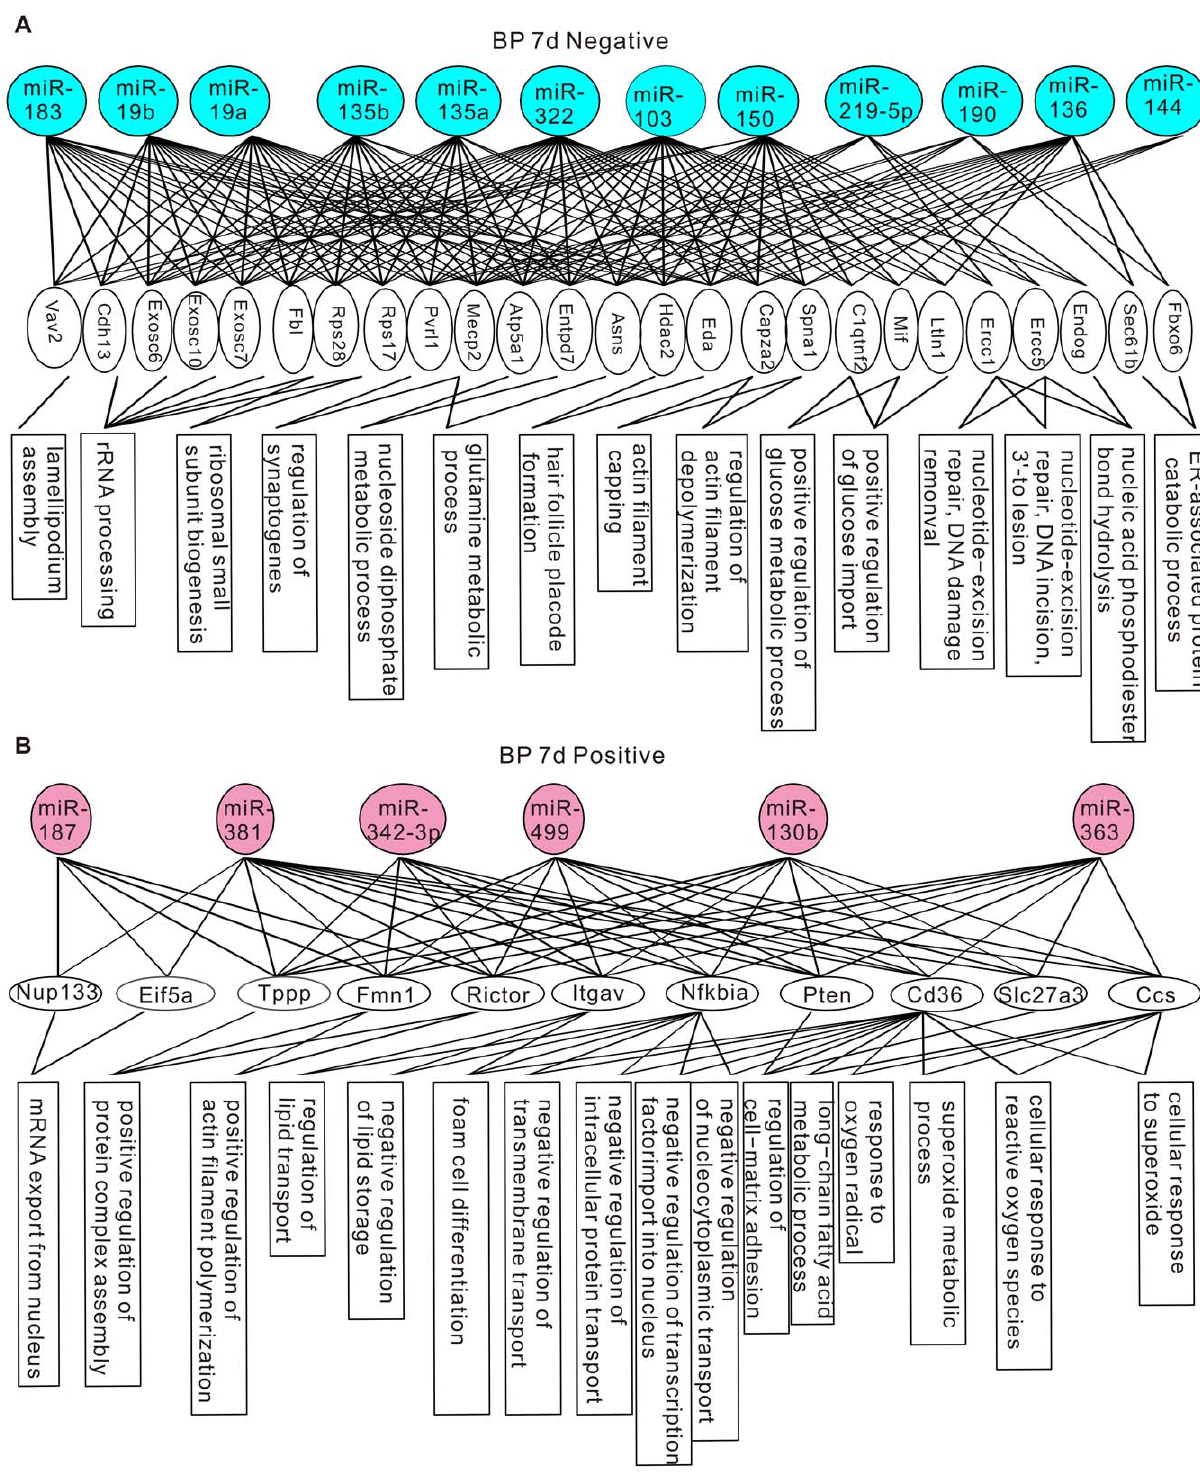
Figure 5. Genes and GO terms in the biological process ontology that are over-represented by differentially expressed miRNAs at 7 days post-CCI. (A) Genes and GO terms enriched by down-regulated miRNAs. (B) Genes and GO terms enriched by up-regulated miRNAs. doi:10.1371/journal.pone.0039357.g005 post-CCI (Table S3). In addition to these functions conserved at signaling pathways (Table S3). Consistent with the overlapping but both time points, at 7 days post-CCI, actin polymerization, cell- different miRNA expression patterns revealed by miRNA matrix adhesion, cellular response to ROS, intracellular traffick- profiling, only intracellular signaling, protein maturation and ing, lipid metabolism and gene expression were targeted by up- alternative splicing were also targeted by miRNAs altered at 7 days